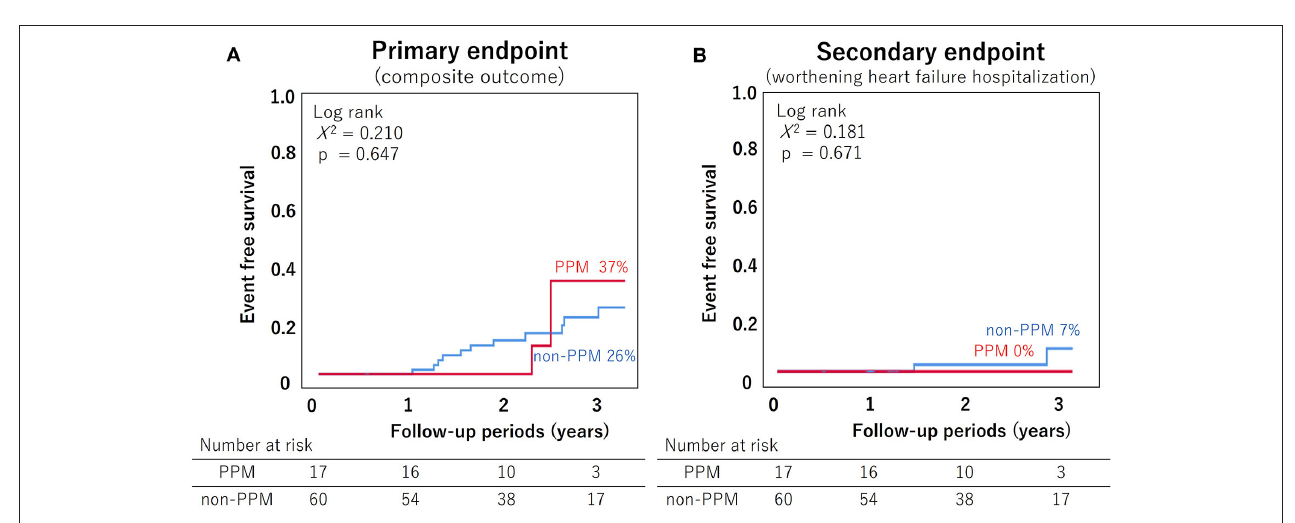
FIGURE 5 | The Kaplan-Meier survival curves for all-cause mortality and heart failure-related hospitalization. (A) Primary endpoint (composite outcomes including all-cause mortality, cardiovascular mortality, cardiovascular event, and heart failure-related hospitalization); (B) Secondary endpoint (heart failure-related hospitalization). There were no differences in the primary and secondary endpoints between the PPM and non-PPM groups. PPM, prosthesis-patient